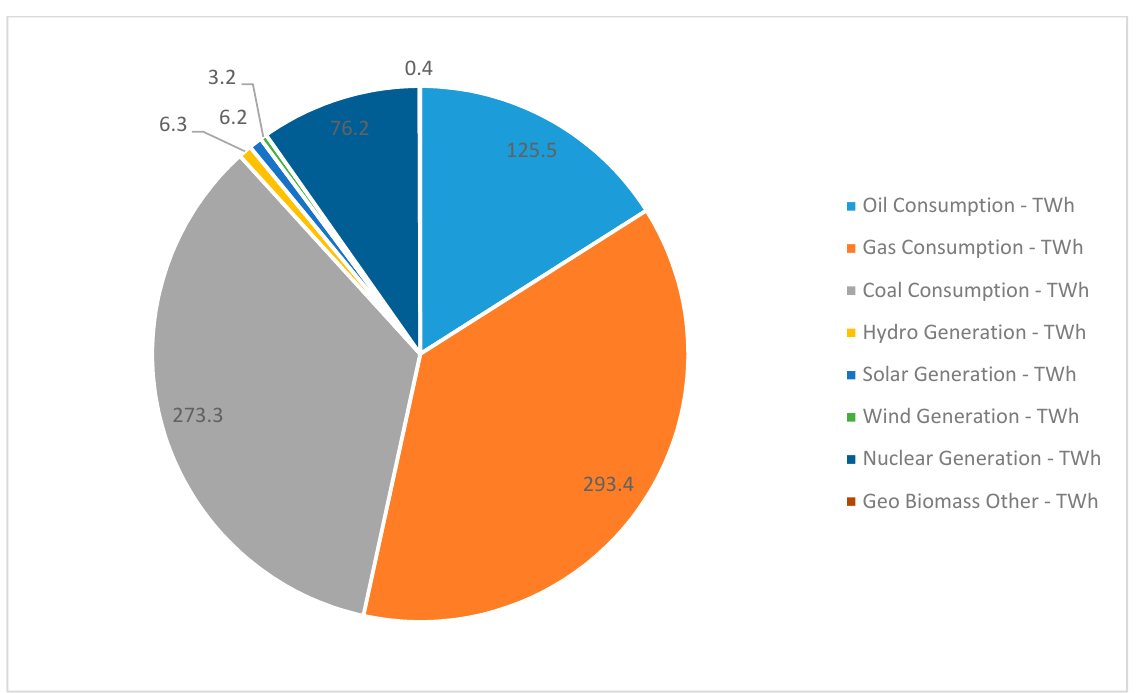
Figure 3. The energy consumption resource distribution in Ukraine in 2020 (according to the data source [14]).